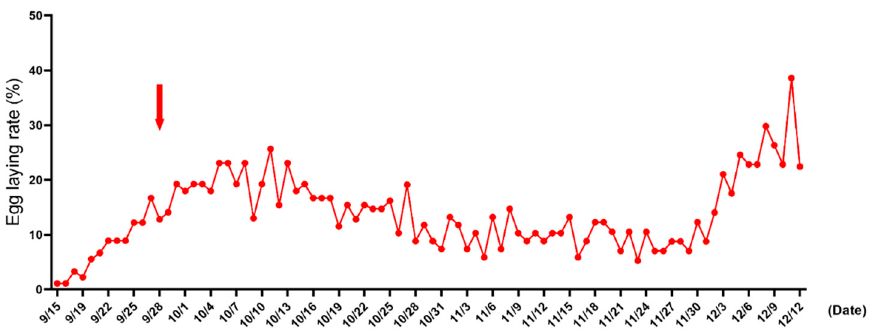
Figure 1. Egg laying rate of Zhedong white geese. The red arrow represents the sampling time point. Table 1. Primer sequences used in this